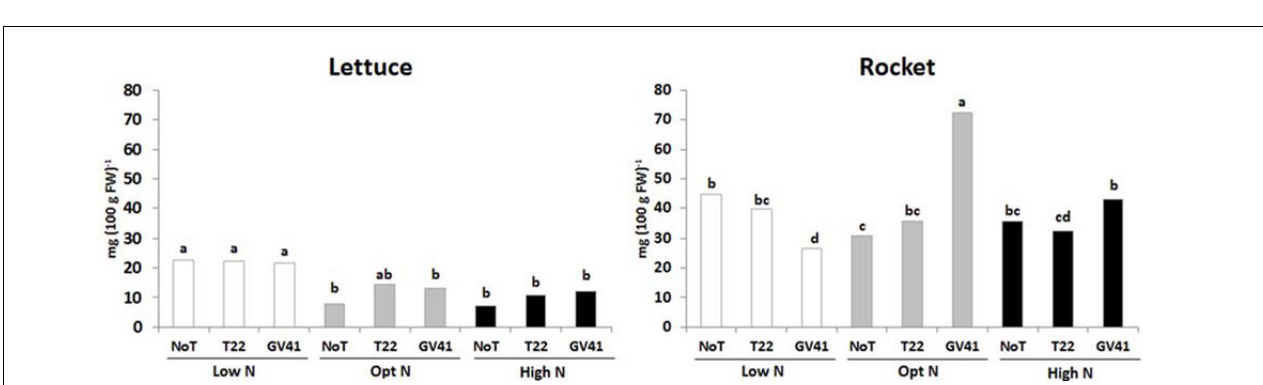
FIGURE 2 | Ascorbic acid content in aboveground lettuce and rocket tissues as affected by N fertilization doses and Trichoderma inoculation. Low N, non-fertilized conditions (low N availability) for both crops; Opt N, optimal N fertilization, amounting to 90 kg N ha − 1 and 60 kg N ha − 1 for lettuce and rocket, respectively; High